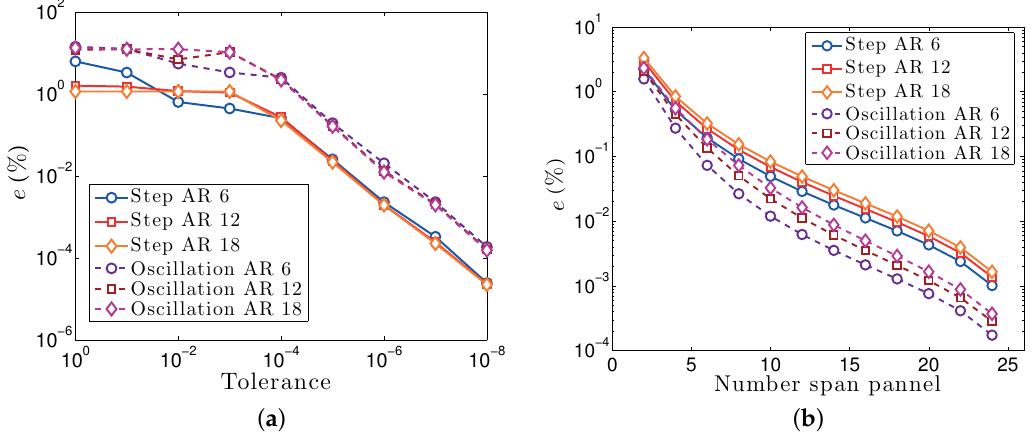
Figure 5. Wagner Lifting Line (WLL) convergence with the tolerance parameter and number of spanwise strips for a rectangular wing. ( a ) Tolerance parameter; ( b ) Number of spanwise